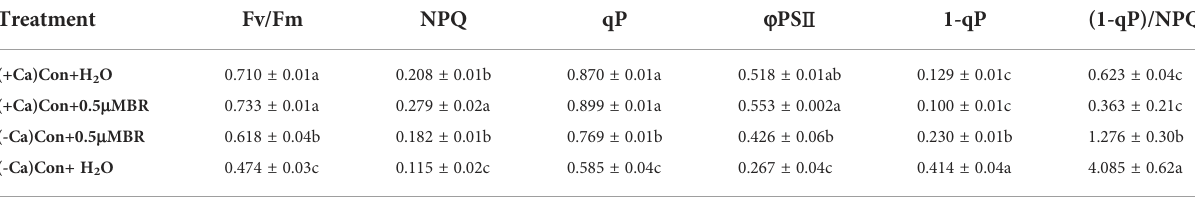
TABLE 2 Effect of exogenous BRs on chlorophyll fl uorescence parameters of mini Chinese cabbage.